Question: Provide a one-line summary of what is displayed.
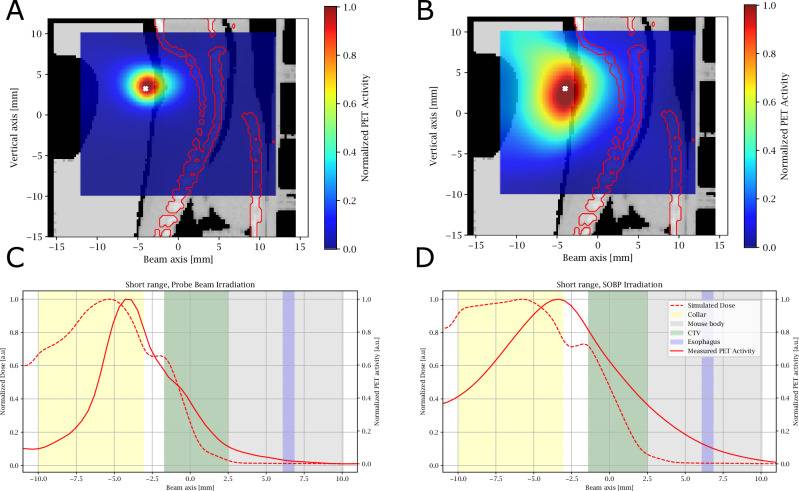
Answer: Irradiation in the “Short” position. A Online SIRMIO PET image of the positron activity distribution acquired during the 11 C-irradiation in the S position with the collimated monoenergetic pristine beam overlaid on the SARRP scan of the mice under irradiation. B Online SIRMIO PET image acquired during the full SOBP irradiation with 20 Gy in the S position. Figure 1B shows the corresponding simulated dose distribution. C , D 1D profiles along the beam direction (z-axis) of the simulated dose (normalized to the target dose; dashed red line) and the measured (solid red) PET activity profiles, normalized to their maximum and laterally integrated on the BEV aperture (±1 mm x, 2–3 mm y) for the monoenergetic and SOBP configuration, respectively. The CTV, esophagus and mouse body are highlighted by green, blue and gray bands, respectively, while the compensator is depicted in yellow. The white “×” marker indicates the position along the beam axis corresponding to the 80% fall-off of the collimated 11 C pure beam distribution.